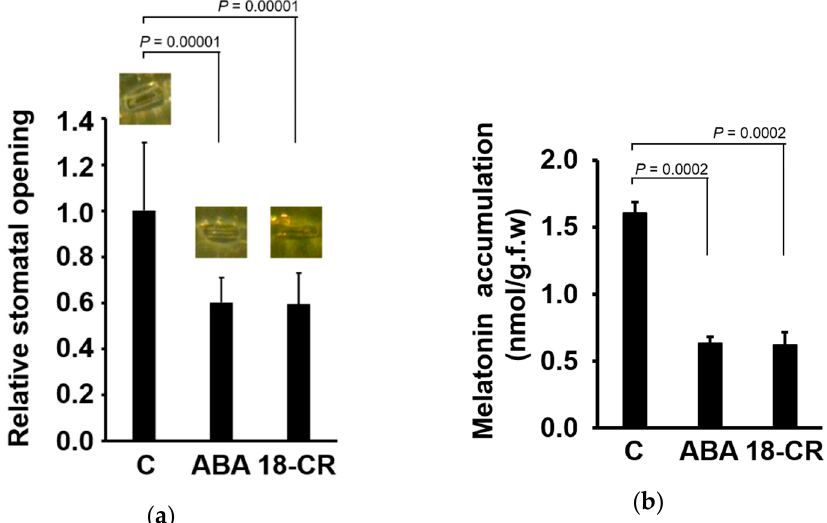
Figure 3. Effect of ABA and benzo-18-crown-6 (18-CR) on stomatal closure and melatonin accumulation. ( a ) The area of stomatal aperture was measured using a digital image equipment and analyzed with ImageJ. ( b ) Effect of ABA and 18-CR on melatonin accumulation in maize leaves. The concentrations of ABA and 18-CR were 10 μ M and 0.1 mM, respectively. Plants were incubated in the presence of 4 mM melatonin for 12 h. Data represent the mean ± SD of at least 18 samples. Statistical significance was determined using Student’s t -test.